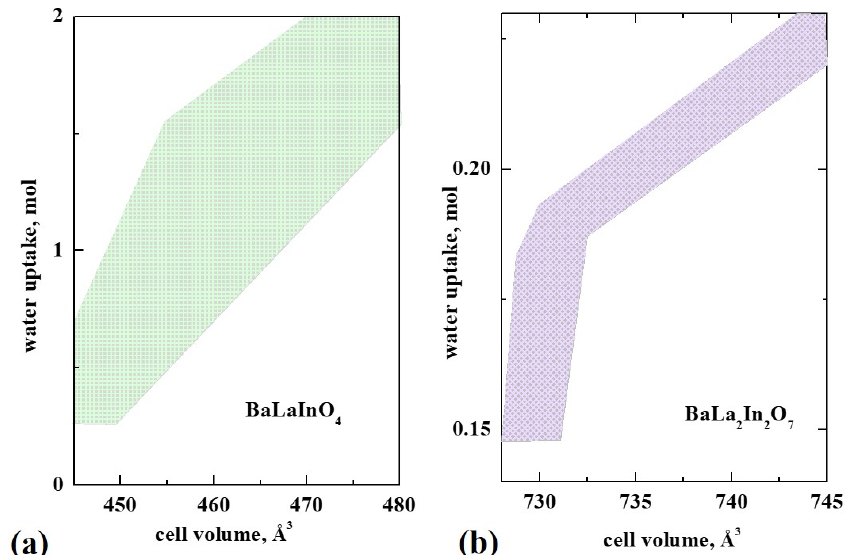
Figure 7. The dependencies of water uptake for doped compositions based on BaLaInO 4 monolayer ( a ) and two-layer BaLa 2 In 2 O 7 ( b ) perovskites.